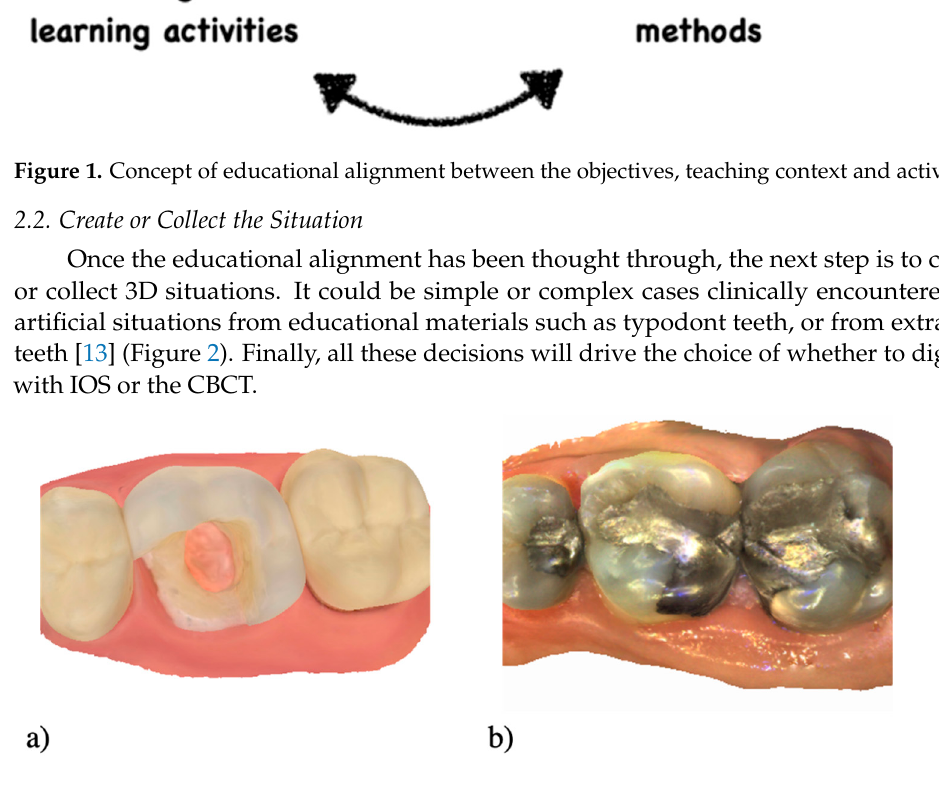
Figure 2. Example of two 3D educational contents using IOS with artificial teeth ( a ) and a clinical situation ( b ). clinical situation ( b